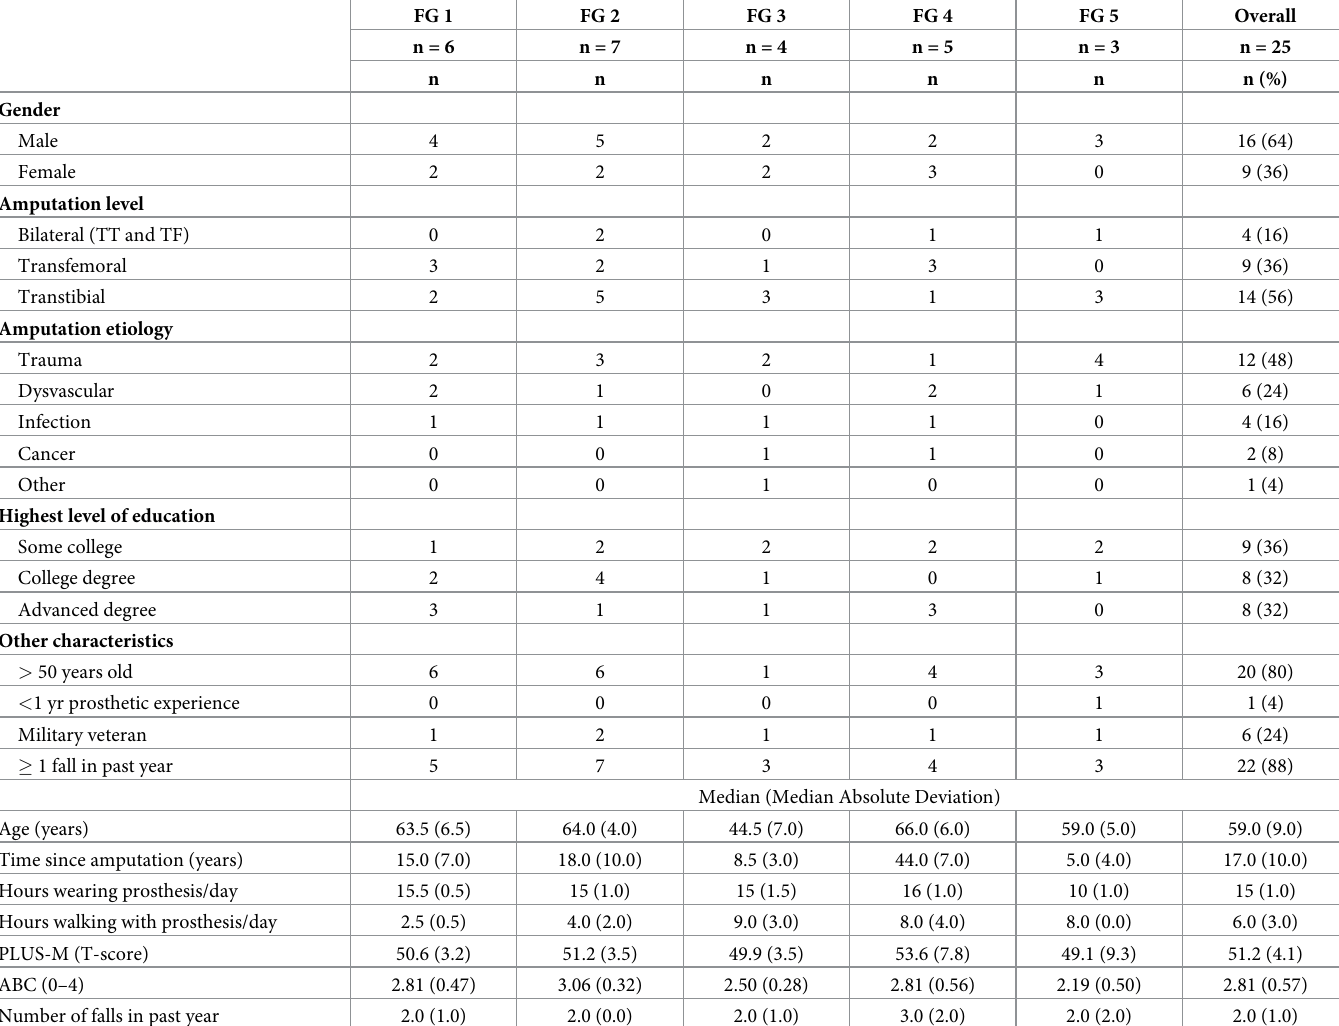
Table 1. Focus group (FG) study participant characteristics (n =